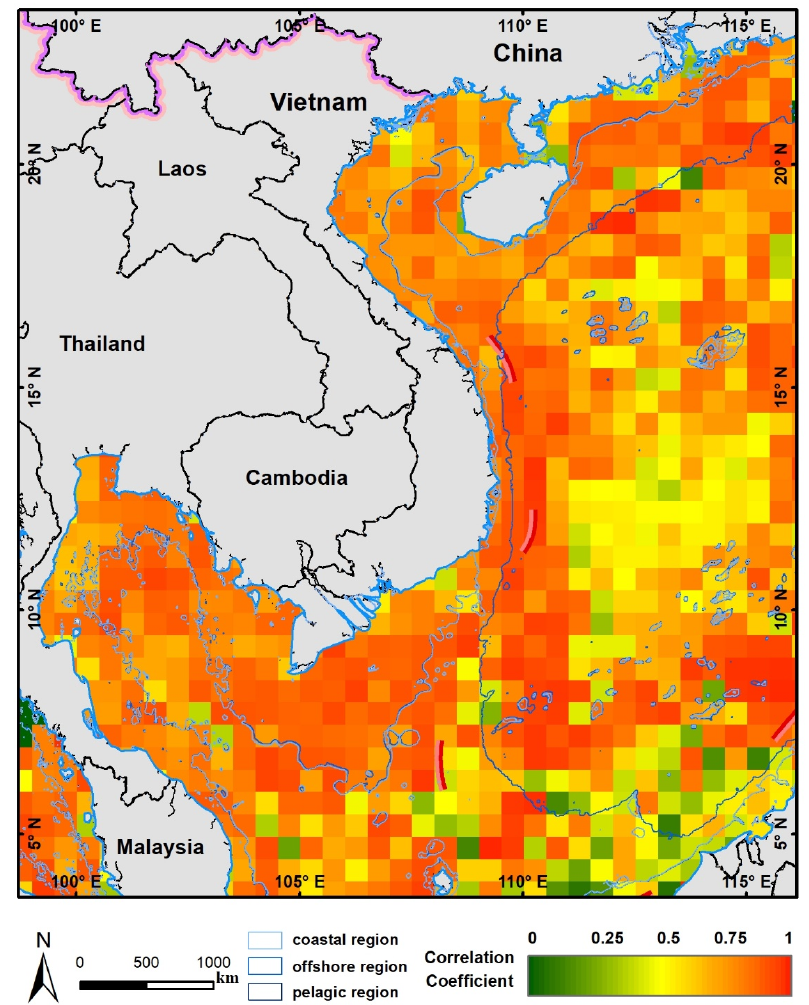
Figure 15. Correlation between the number of nighttime fishing boats and TOL.